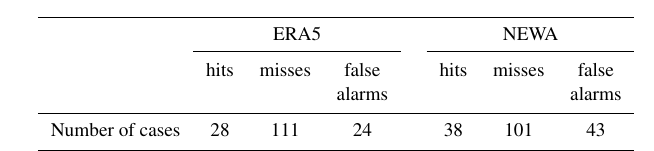
Table 4. Number of hits, misses, and false alarms for each numeri- cal